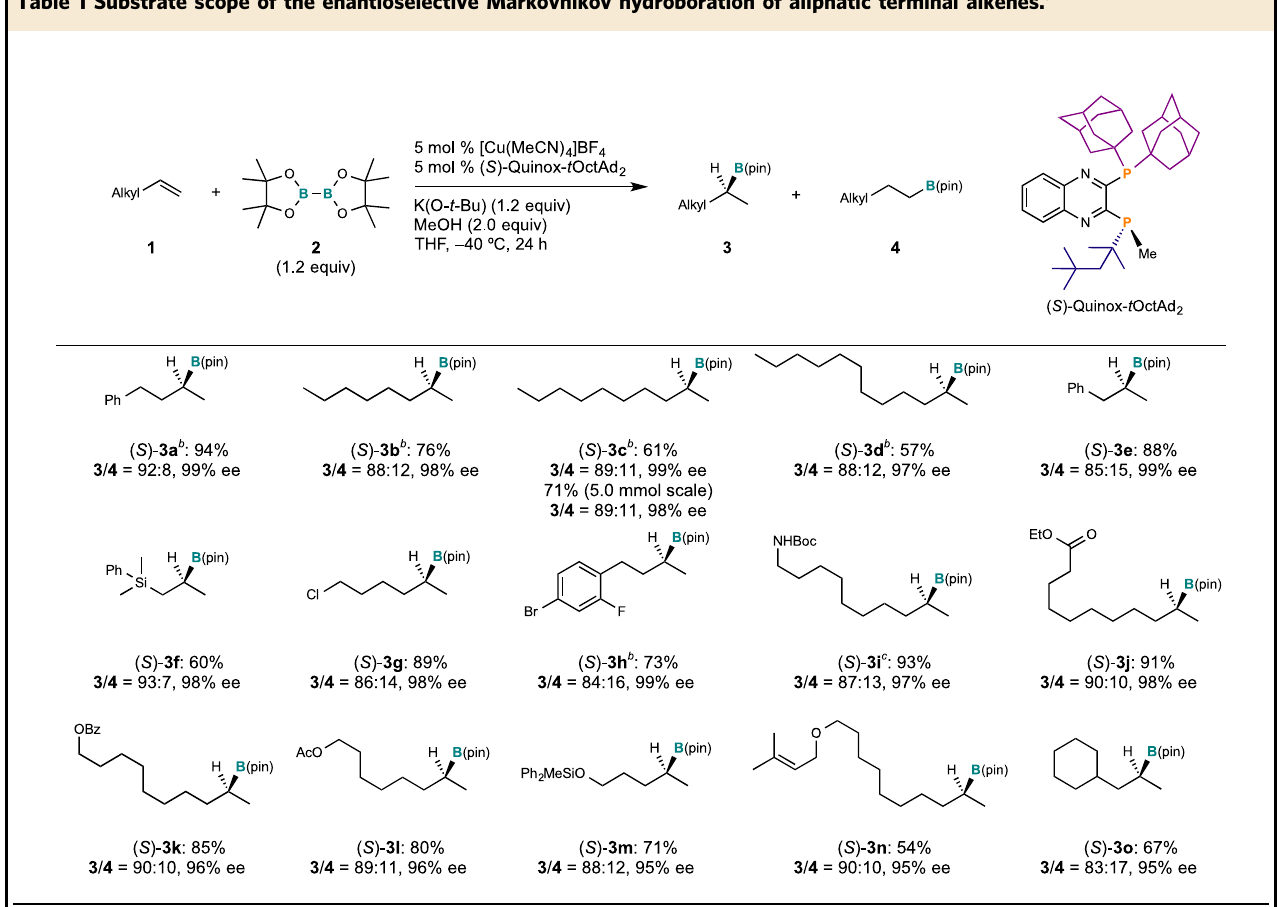
Table 1 Substrate scope of the enantioselective Markovnikov hydroboration of aliphatic terminal alkenes.